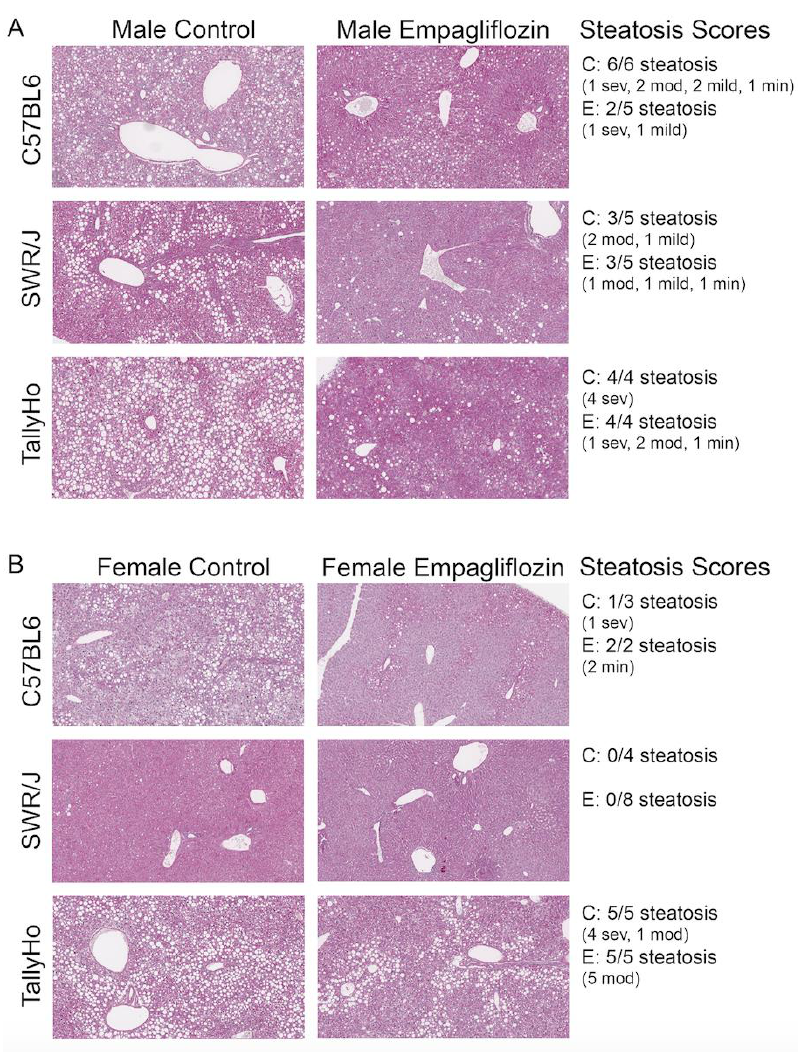
Figure 5. Empagliflozin attenuates hepatic steatosis. Livers from control and Empagliflozin-treated mice were isolated, stained for PAS, and imaged. Both male ( A ) and female ( B ) control mice fed a high milk-fat diet exhibited severe steatosis. Steatosis scores decreased in all of the Empagliflozin-treated mice with the exception of the SWR/J females where steatosis was not detected. Sev: severe; mod: moderate; min: minimal.